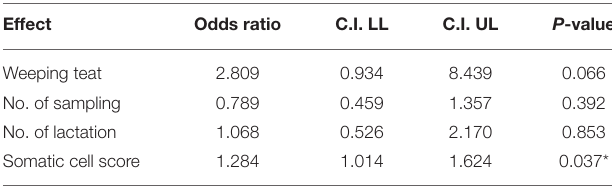
TABLE 2 | Results of the linear general mix model on four herds sampled in 2018 on fixed effects in Model 1.